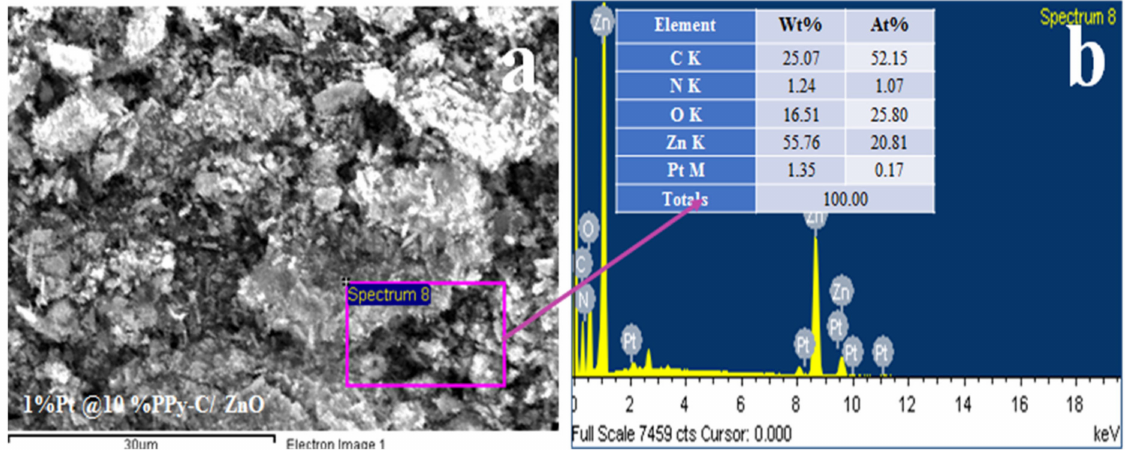
Figure 2. EDS analysis of Pt NPs- embedded PPy-CB@ZnO NCs; ( a ) Higher magnifying image of Pt-NPs PPy-CB@ZnO NCs and ( b ) Elemental composition spectrum of synthesized Pt NPs- embedded PPy-CB@ZnO NCs (Composition of elements; Inset;